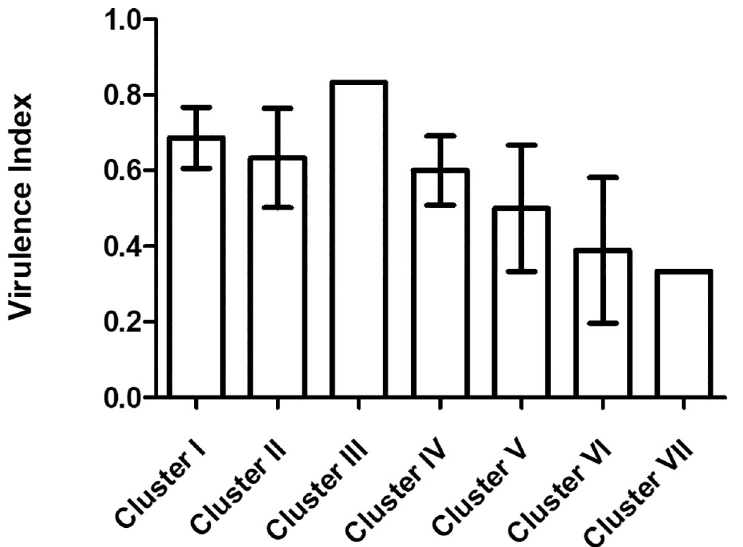
Fig 6. Virulence index by bacterial